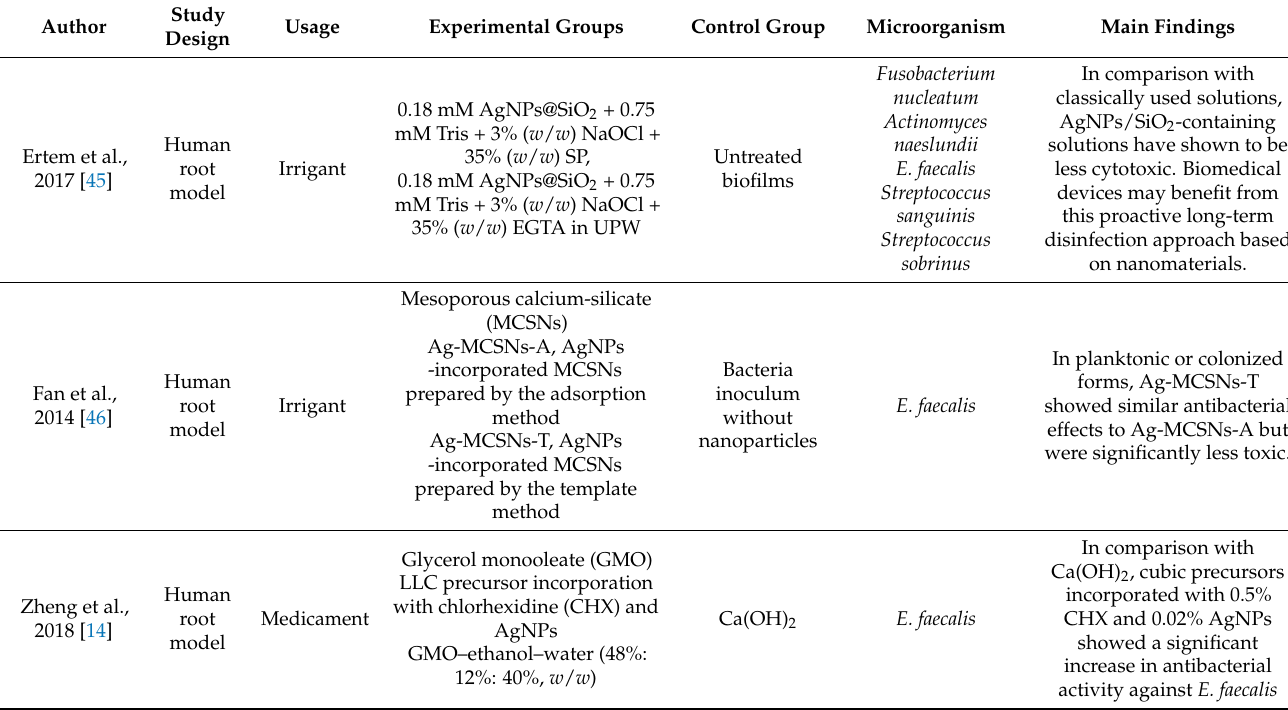
Table 1. Studies of alternative antimicrobial strategies highlighting antimicrobial type, study design, usage, experimental and control groups, microorganisms tested, and main